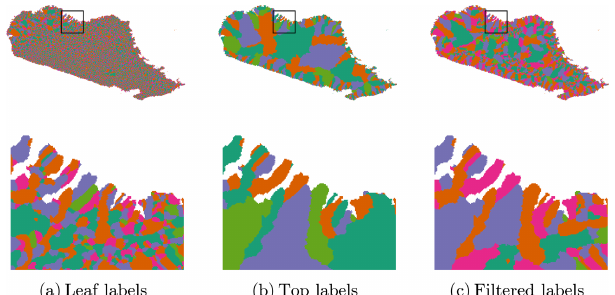
Figure 9. Depression hierarchies applied to Madagascar: depres- sion labels. The Label array of the depression hierarchy algorithm is shown here for three situations. The top row depicts all of Mada- gascar, while the bottom row depicts the zoomed areas identified by the black boxes. Since there are too many labels to show in distinct colors the labels have instead been colored so that no two adjacent depressions have the same color using a largest-first greedy algo- rithm (Kosowski and Manuszewski, 2004; Hagberg et al., 2008). Panel (a) depicts the labels assigned to the leaf nodes of the depres- sion hierarchy. Panel (b) depicts the labels assigned to the upper- most parent depressions – those that connect directly to the ocean. These are the top-level watersheds of the island. Panel (c) depicts the labels after depressions less than a given threshold (30 cells in area) are detected by filtering and removed via carving.